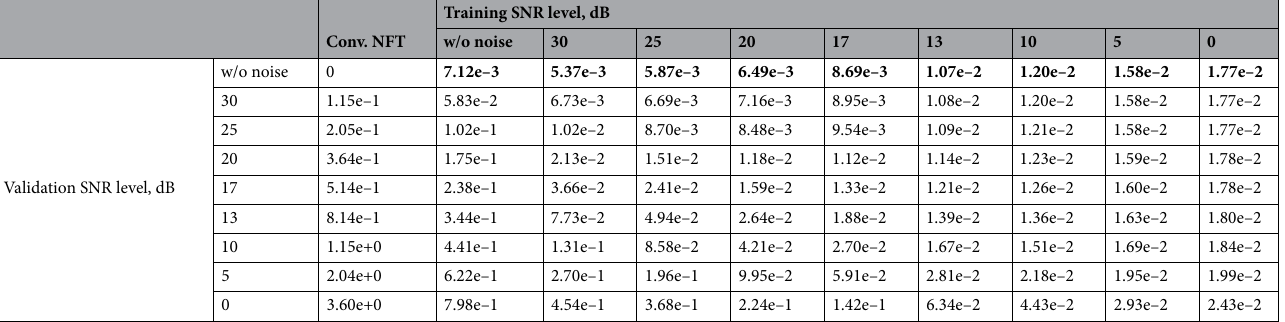
Table 2. Comparison of the NFT-Net performance against the fast conventional NFT in the computation of coefficient b (ξ) . The table presents the results for the NFT-Net architecture from Fig. 3. The values in the cells show the error value (5) for each specific pair of training and validation sets SNR. The bold cells correspond to the cases when the accuracy of the NFT-Net nonlinear spectrum restoration is lower than that of fast NFT, i.e. the NN does not denoise the signal well, while the white cells correspond to the cases when the accuracy of the continuous NF spectrum rendered by the NFT-Net is higher, i.e. the NN effectively denoises the signal.